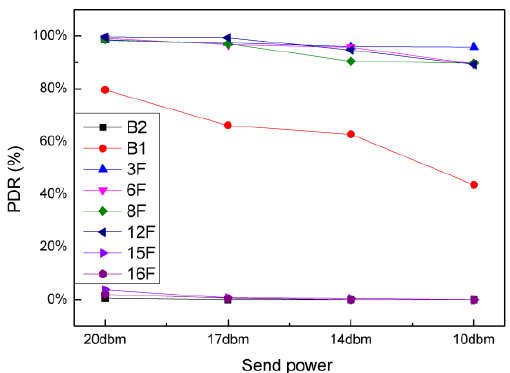
Figure 15. Relationship between PDR and send power in the different floors.